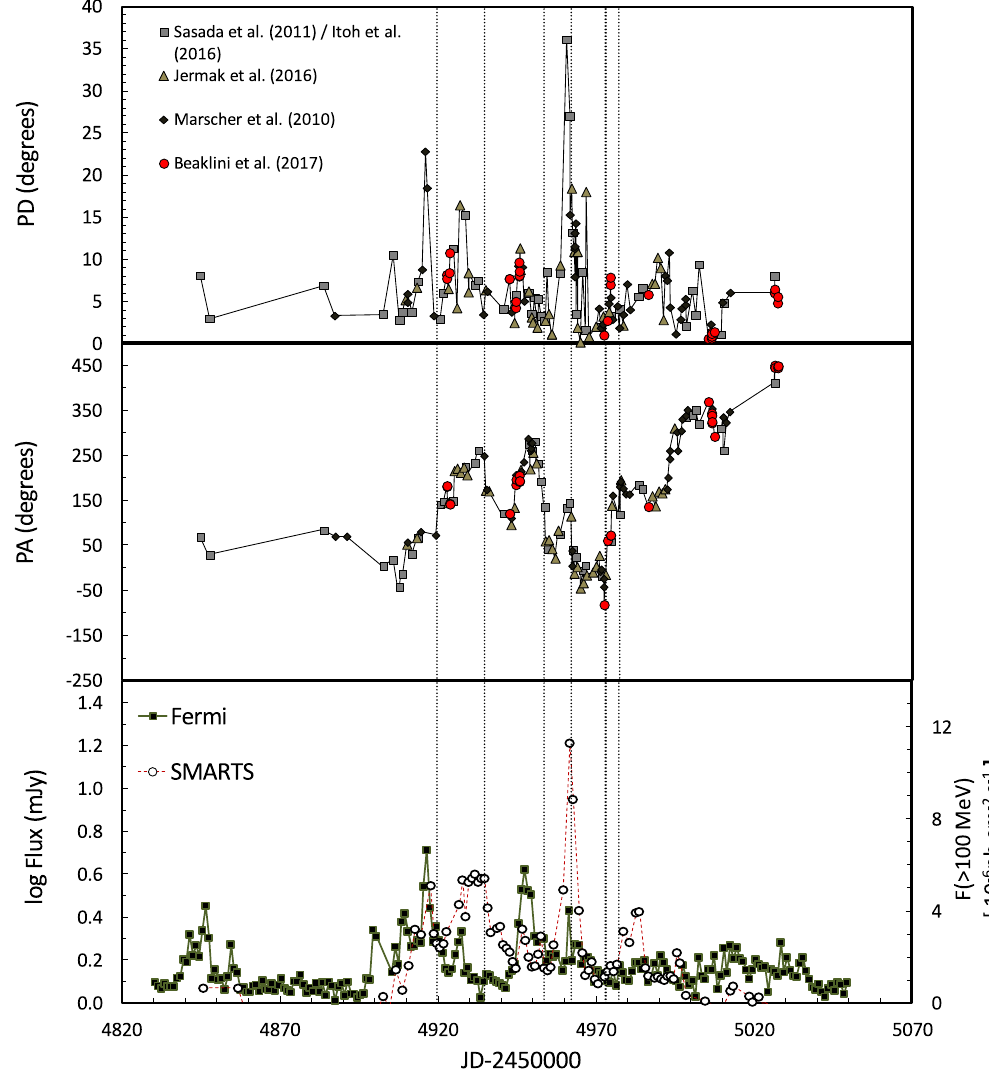
Figure 4. Polarization degree and angle variability pattern using all the data available in the literature. We used the criterion of keeping the difference between two consecutive measurements smaller than 90 o to solve the 180 o multiplicity. We indicated by dashed lines the epochs in which large variations of the polarization angle in short timescales took place, and at least two of them seem to be coincide with to the occurrence of optical